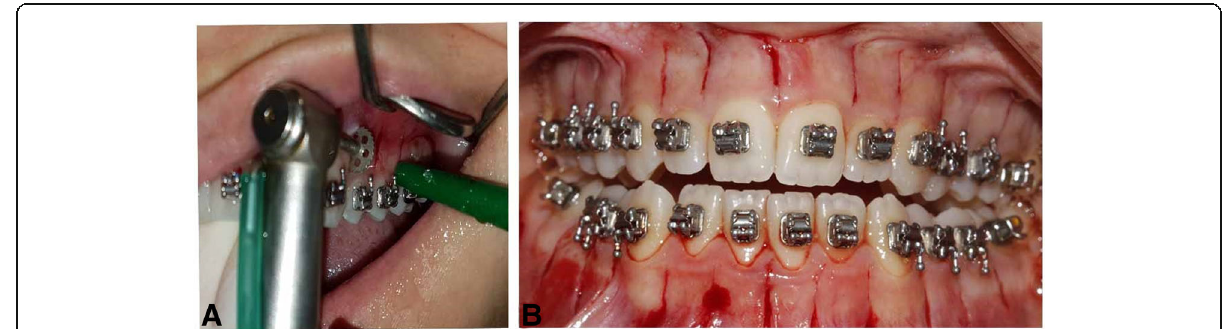
Fig. 1 a Intraoral discision application. b Discision post-operative view